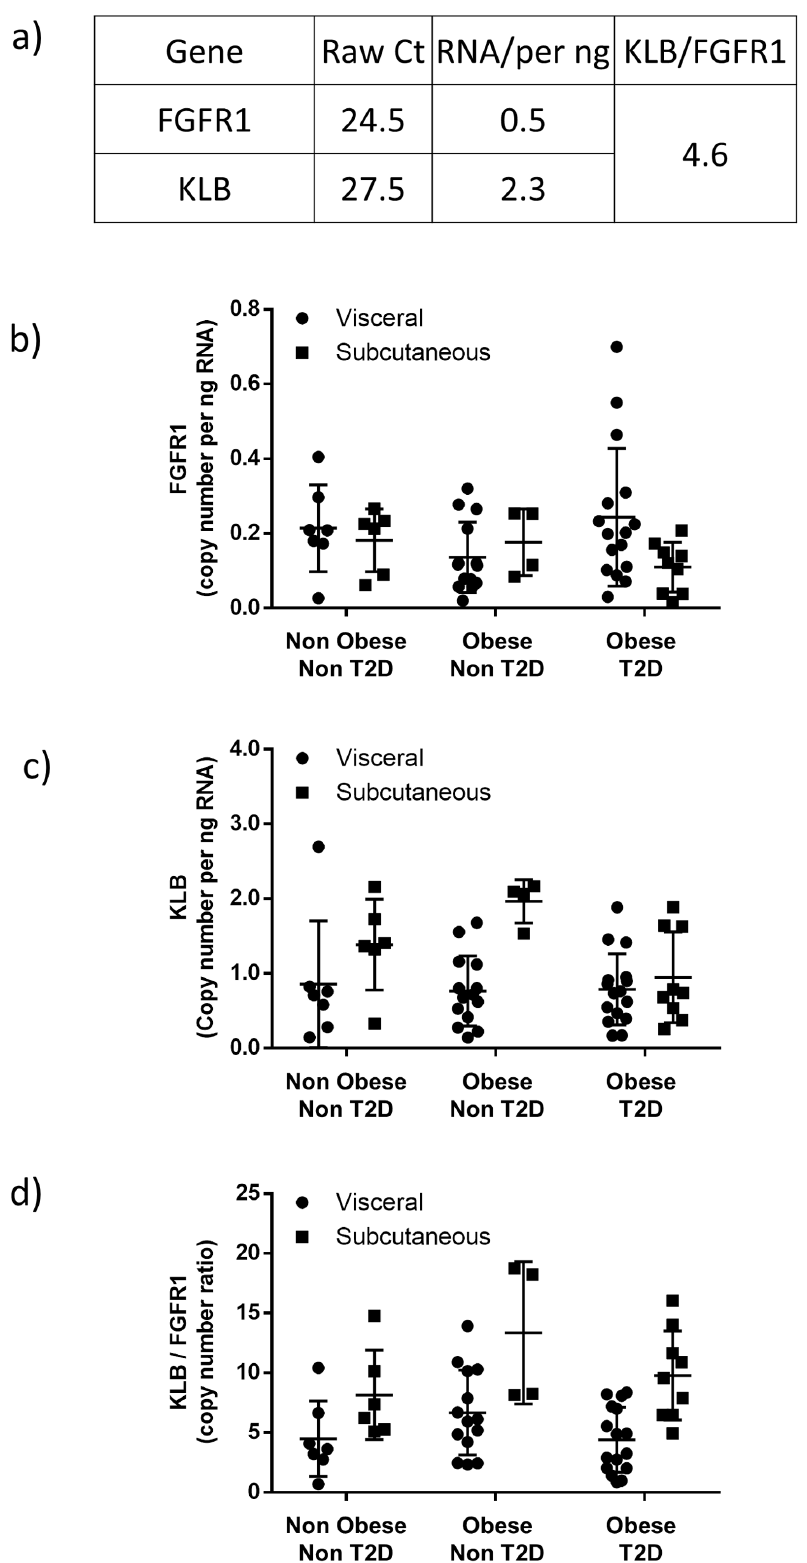
Figure 1. Expression of FGFR1 and KLB are consistent in hASCs and human adipose tissue. FGFR1 and KLB mRNA in a) hASC-adipocytes, b) human subcutaneous (SC) and visceral (Vis) adipose tissue. c) Ratio of KLB:FGFR1 in human SC and VIS adipose tissue. n=7 lean normal, n=6 obese non T2D and n=10 obese T2D.